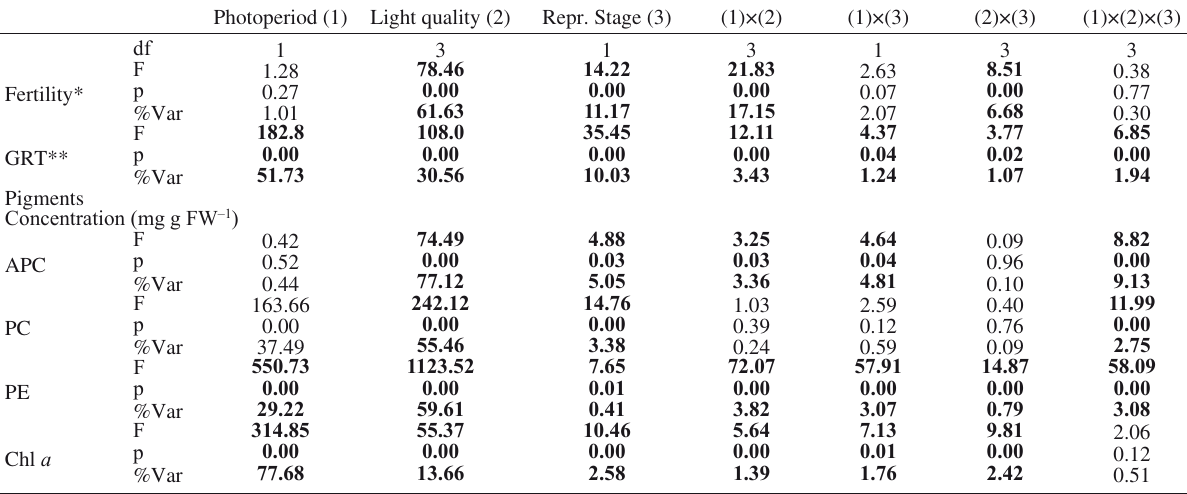
Table 1. – Results of a three-way ANOVA showing isolated and interactive effects among independent variables. Data were obtained for tetrasporophytes and gametophytes of Gracilaria birdiae cultivated under two photoperiods and four light qualities. GRT, growth rate; APC, allophycocyanin; PC, phycocyanin; PE, phycoerythrin; Chl a , chlorophyll a . Bold values indicate significant data with a confidence interval of 95% ( a <0.05). n=3. * Regardless of time; ** Considering GRT obtained between the third and the sixth